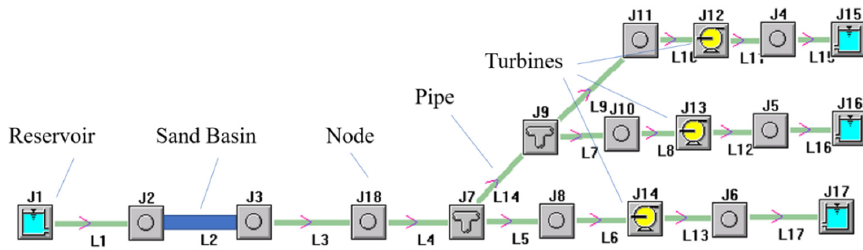
Figure 7. Modelling of the hydropower system in TOPSYS. Table 1. Basic information about the hydropower station.